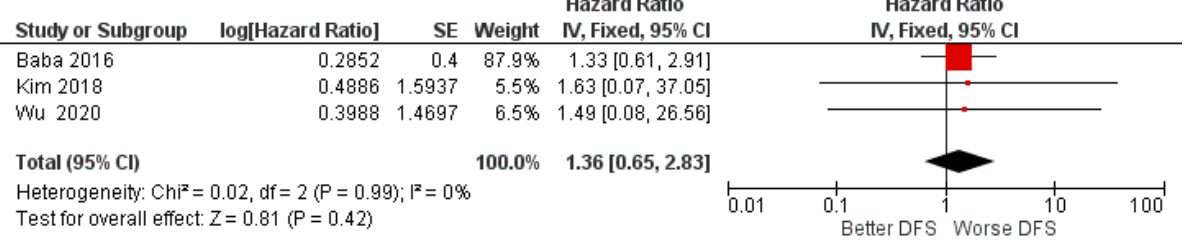
Figure 3. Forest plot of the fixed effects model of the meta-analysis; DFS, HR = 1.36, 95% CI: [0.65 2.83].